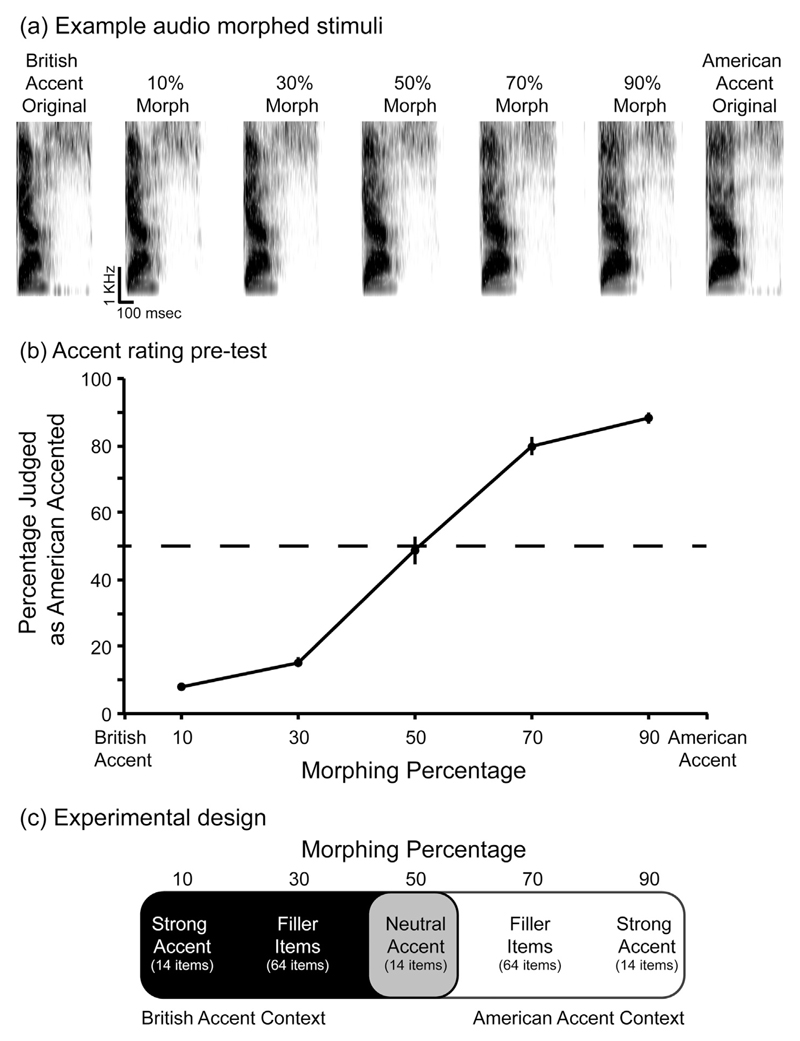
Stimuli, pilot data and method for Experiment 2. (A) Spectrograms of a single word “gas” spoken in a British Accent (leftmost panel), an American Accent (rightmost panel) and resynthesized at intermediate levels of accent strength using STRAIGHT software. (B) Results of the accent rating pre-test showing that 50% morph stimuli are perceived equally often as British or American (broken horizontal line shows 50% American responses). Error bars show ±1 SE over participants. (C) Design for Experiment 2 in which neutral-accent tokens are paired with strong-accent tokens in a British or American accent context.